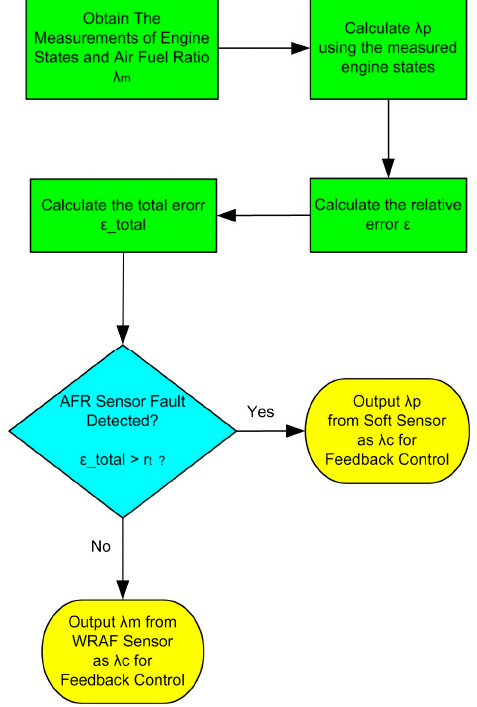
Figure 8. Flowchart for fault-tolerant module operation. WRAF: wide-range air fuel.